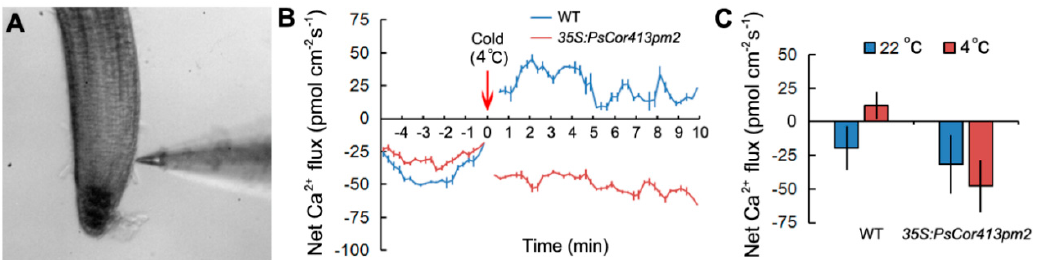
Figure 6. Effect of cold shock on net Ca 2+ flux in the root elongation zone of transgenic Arabidopsis and wild type (WT) seedlings. ( A ) The root zones of Arabidopsis seedlings as measured using non-invasive micro-test technology (NMT). ( B ) Ca 2+ kinetics recorded after a cold (4 °C) solution was added (at red arrow) to the chamber are shown. Prior to the cold shock, Ca 2+ fluxes in roots were examined for approximately 5 min at room temperature (22 °C). ( C ) The mean Ca 2+ flux rate in the root elongation zone of transgenic Arabidopsis plants (#10) overexpressing PsCor413pm2 , as well as WT plants during the period of cold shock is shown. Error bars show the SE of the values from six replicates.